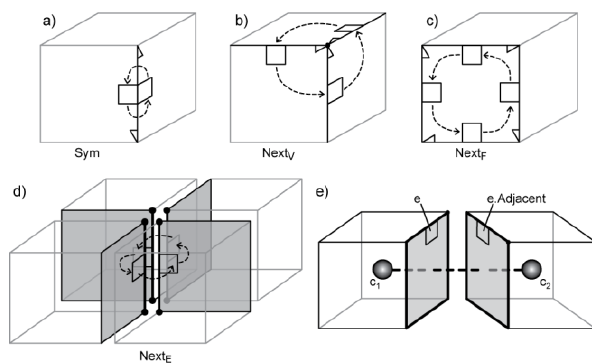
Figure 2. Navigation operators: a) Sym, b) Next V , c) Next F , d) Next E , e) Adjacent (Boguslawski and Gold, 2016).